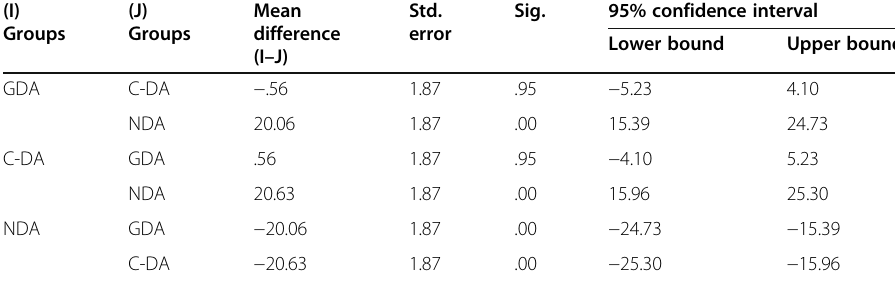
Table 5 Results of the Scheffe post hoc test for comparing GDA, C-DA, and N-DA mean scores on the speaking accuracy